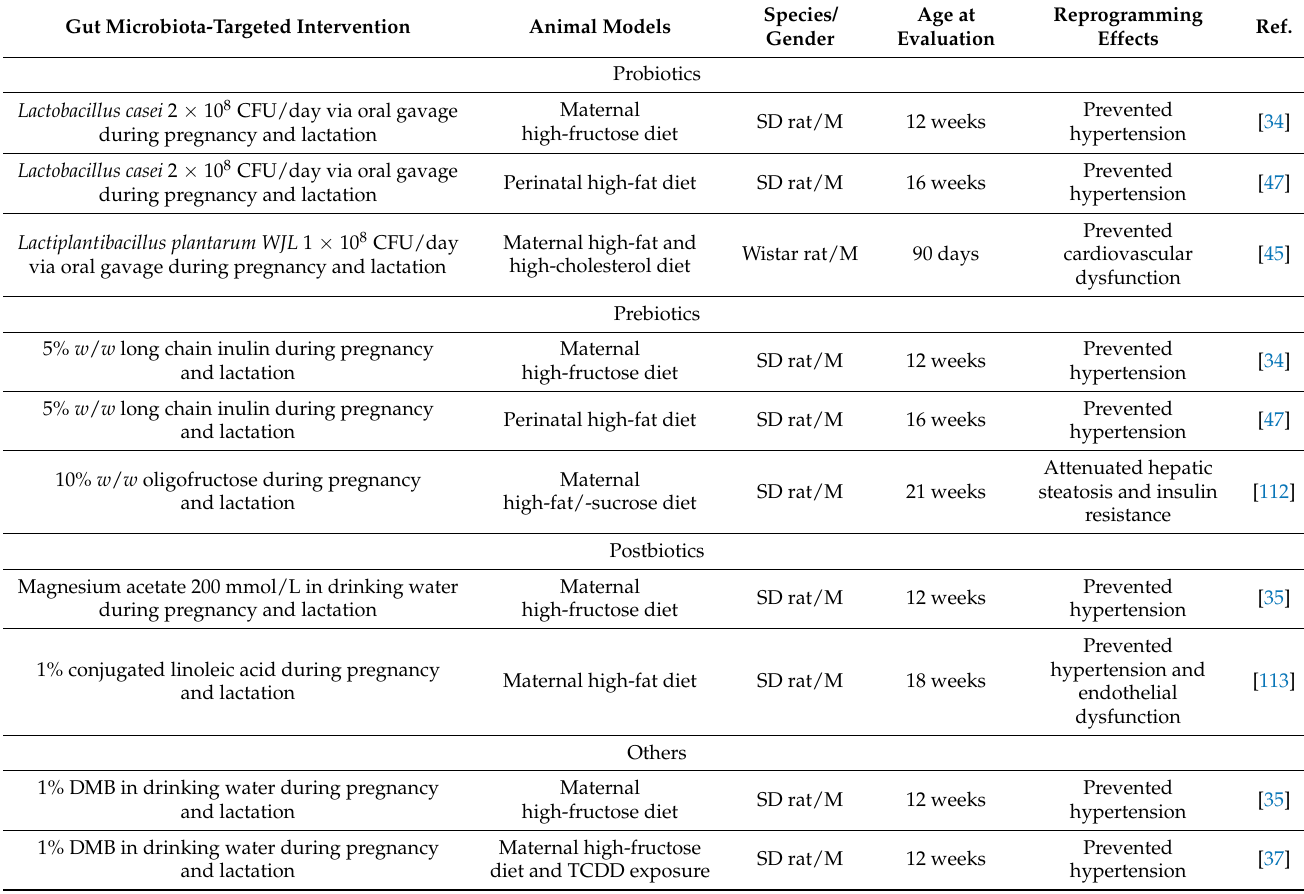
Table 2. Summary of gut microbiota-targeted modalities used as reprogramming interventions for cardiovascular disease of developmental